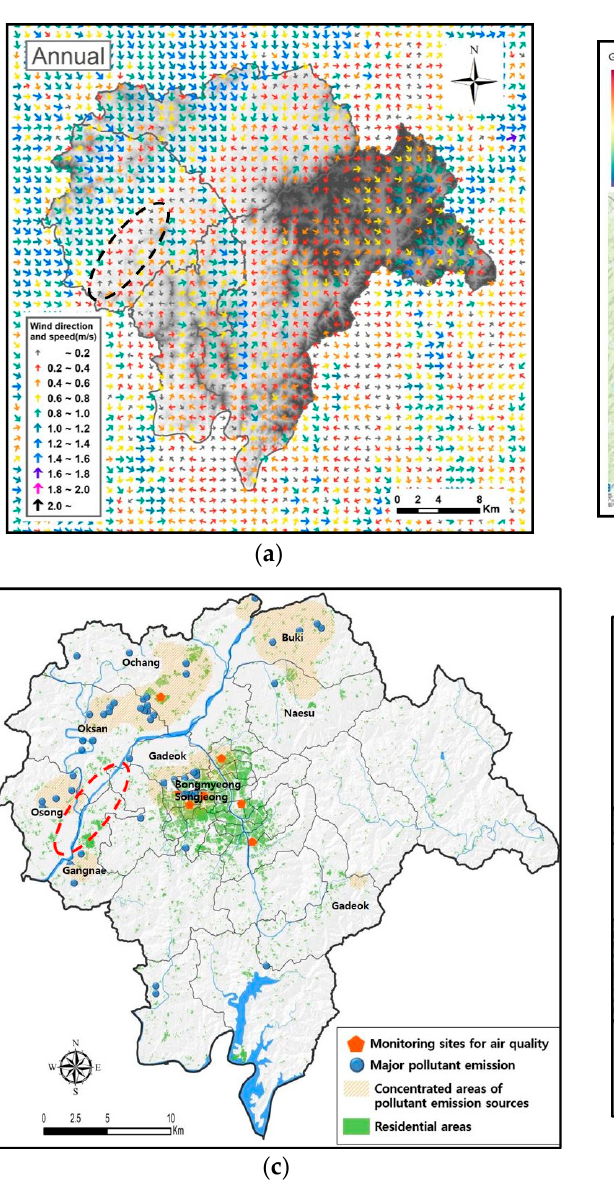
11 of 17 Figure 5. Wind field map of Cheongju-si, Korea by season: ( a ) spring, ( b ) summer, ( c ) autumn, ( d ) winder. 4.3. Implication of Wind Field Maps to Environmental Plan in Cheongju-Si When the wind field map of this study was combined with data regarding the distri- bution of air pollutant emission sources and residential areas, useful information was gathered for informing decision making regarding the improvement of air pollution con- ditions and the creation of a more comfortable air environment (Figure 6). Here, both the wind field map derived from the application of the WRF and CALMET models (Figure 6a), and the wind field map of the Cheongju-si EP, with the application of the CAS model